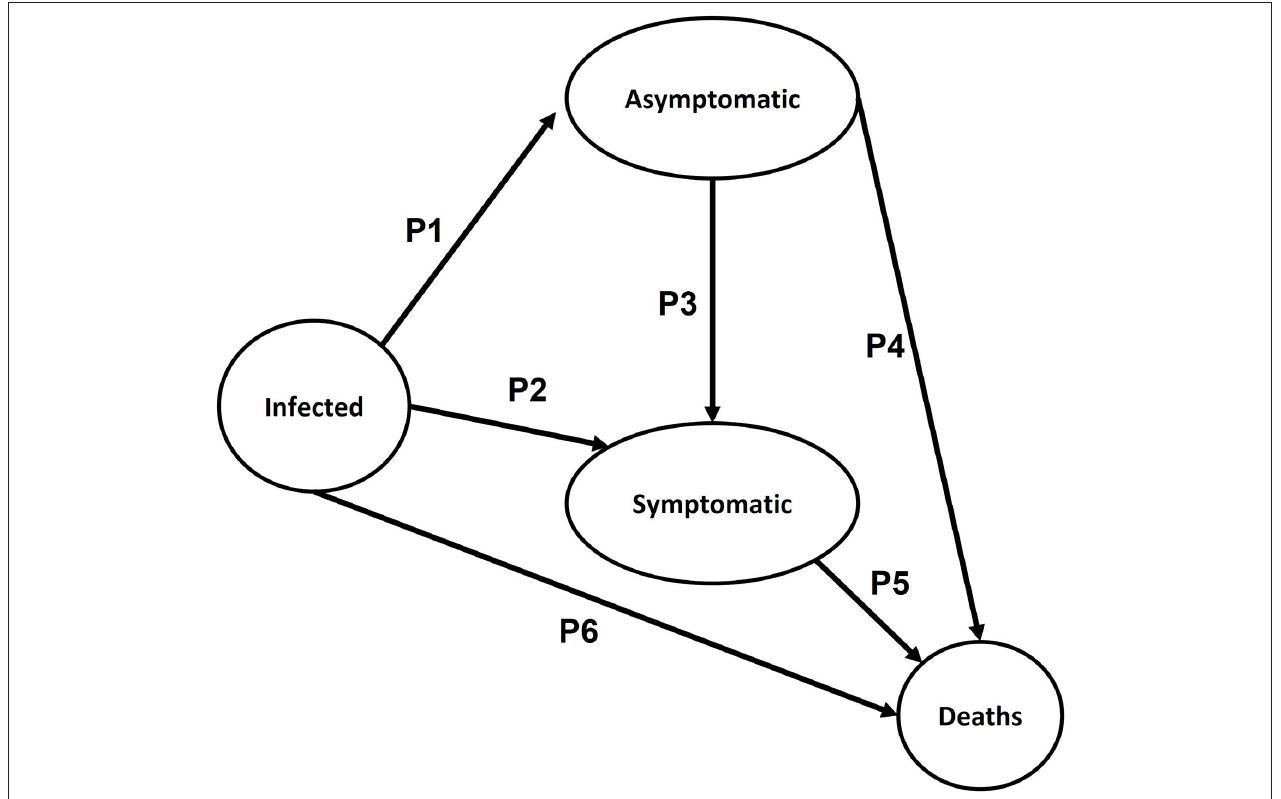
FIGURE 1 | Diagram of Markov’s Model for cost–utility analysis (CUA) for general/early HIV screening vs. only to high-risk population and the use of